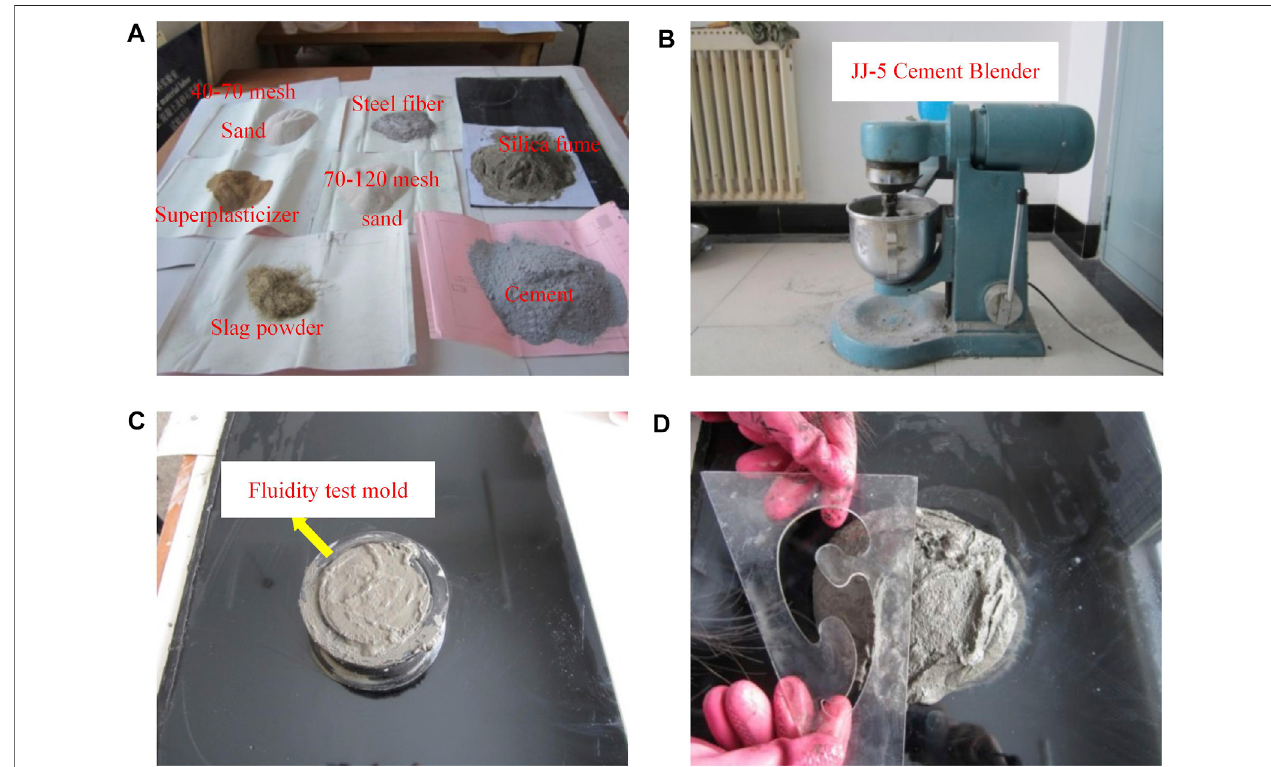
FIGURE 1 | Mixing process: (A) Weighing of components; (B) mixing of materials; (C) fl uidity test mold; (D) fl uidity